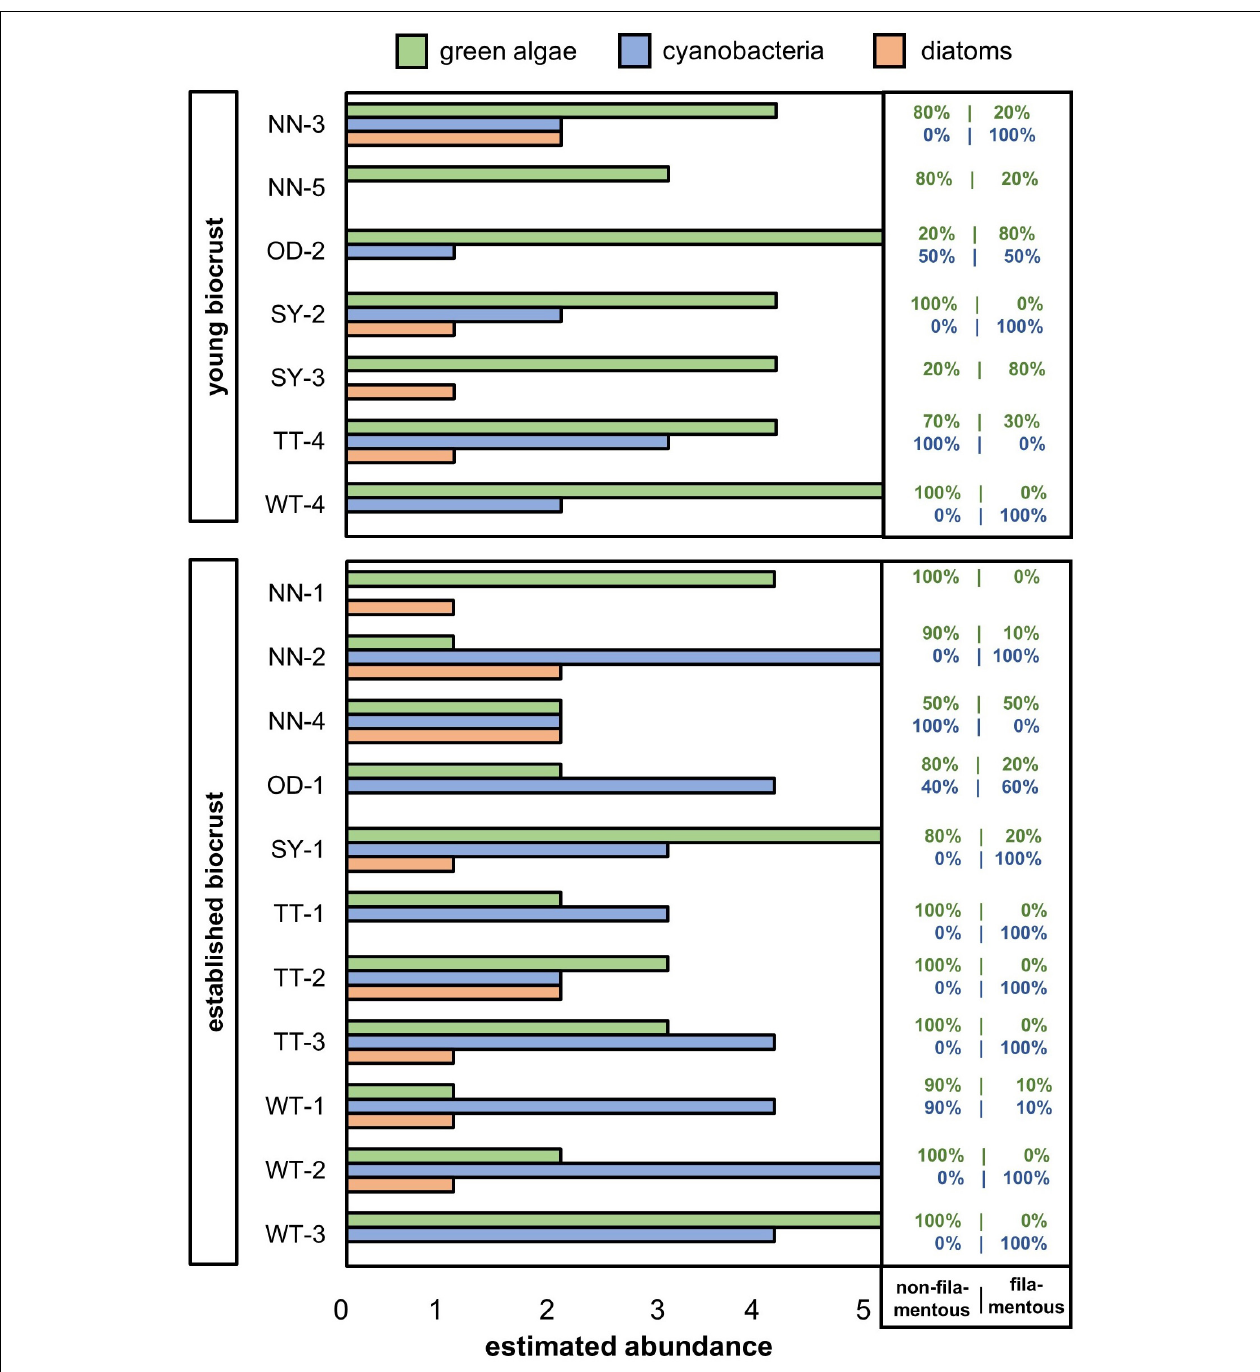
FIGURE 3 | Estimated abundance of major algal groups in young and established biocrusts from potash tailings pile sites (OD, Oedesse; SY, Shreyahn; TT, Teutschenthal; WT, Wietze; NN, not further described) determined by direct microscopy of biocrust material. The estimated percentage of filamentous and non-filamentous green algae (green) and cyanobacteria (blue) are noted on the right; all observed diatoms were